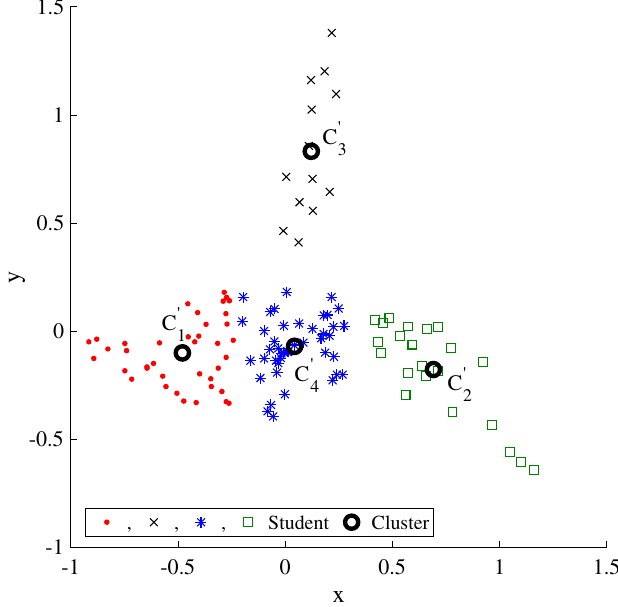
FIG. 6. K -means graph of the 4-cluster partition of our data. Each point in this Cartesian plane represents a student. Points labeled C 1 , C 2 , C 3 , and C 4 are the centroids. The x and y axes simply report the values needed to place the points according to their mutual distance.